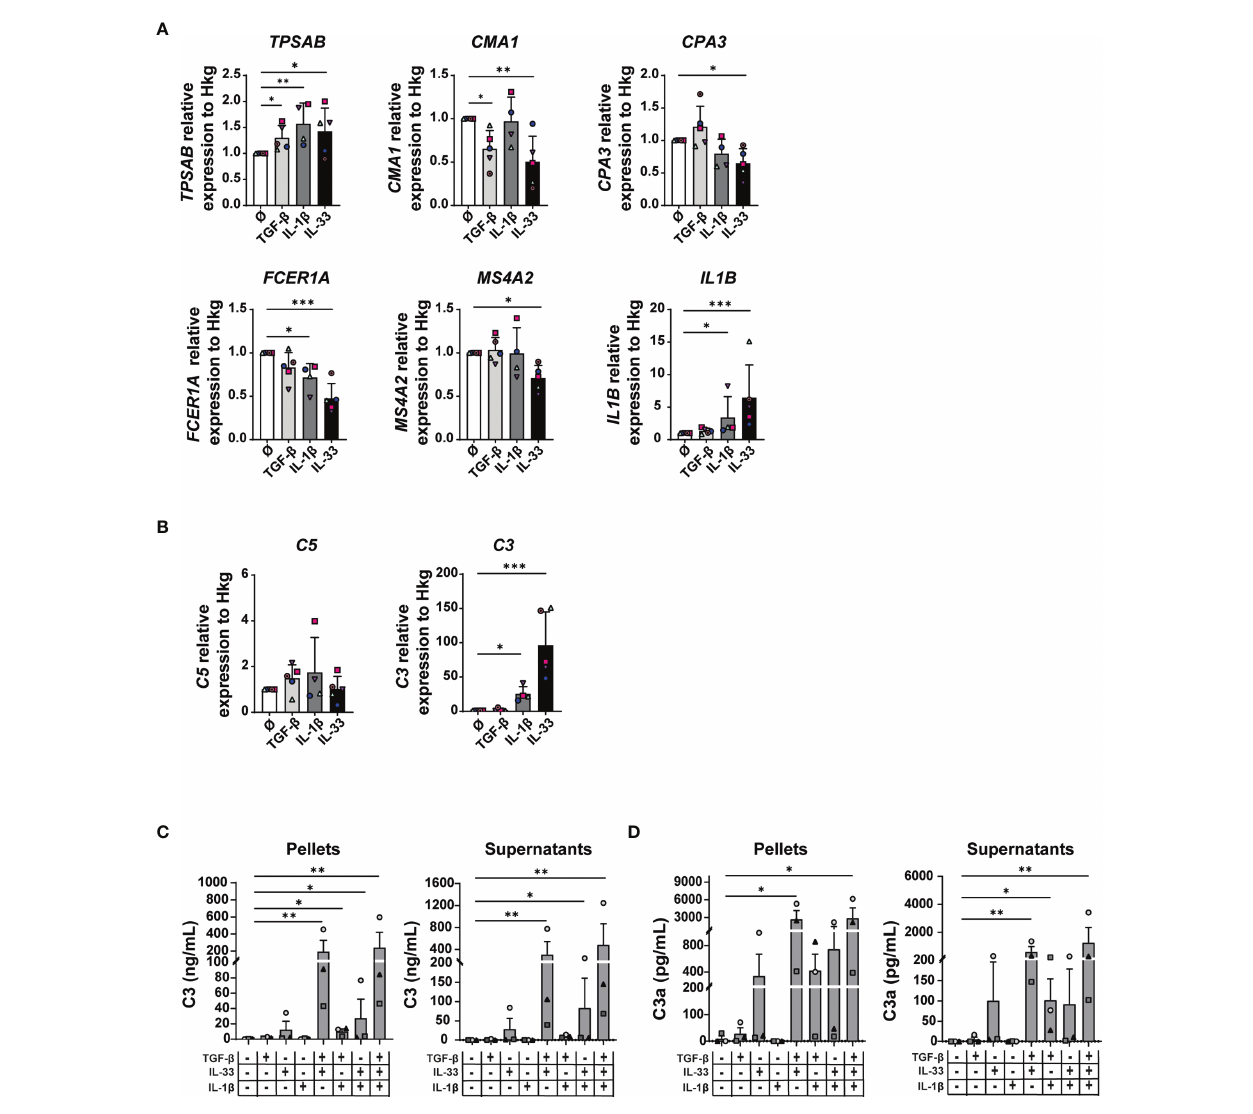
FIGURE 6 | TGF- b , IL-33, and IL-1 b induce some of the changes found in MAMCs. MCs were treated 48 h with 50 ng/ml of TGF- b 1, IL-1 b , and IL-33 cytokines alone or in different combinations as indicated. Tryptase ( TPSAB ), chymase ( CMA1 ), carboxypeptidase A3 ( CPA3 ), Fc e RI a ( FCER1A ), MS4A2 ( MS4A2 ), and IL-1 b ( IL1B ) (A) and C3 and C5 (B) mRNA levels were measured by RT-PCR and normalized by the mean of three housekeeping genes ( PPIA , 18S , and H3-3B ). Data were normalized to medium-treated control samples (Ø). Data represent the mean ± SEM of four independent experiments ( n = 4 – 5) in (A, B) . Quanti fi cation of C3 protein in MC pellets and supernatants was performed by ELISA (C) . C3a was measured using CBA (D) . Results are shown as mean ± SEM of three independent experiments ( n = 3) in (C, D) . One-way ANOVA statistical test was used; * p < 0.05, ** p < 0.01, *** p <